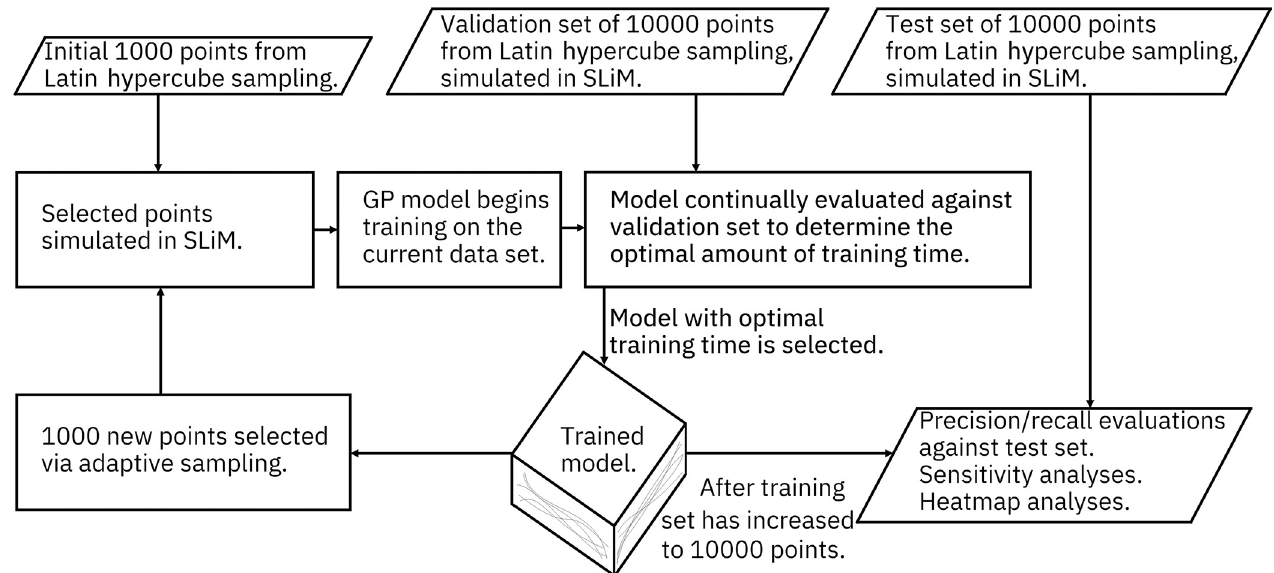
Fig 1. Gaussian Process model schematic. The training set started as 1000 randomly sampled points, and the models were considered complete after the training set had been iteratively grown to 10000 points.